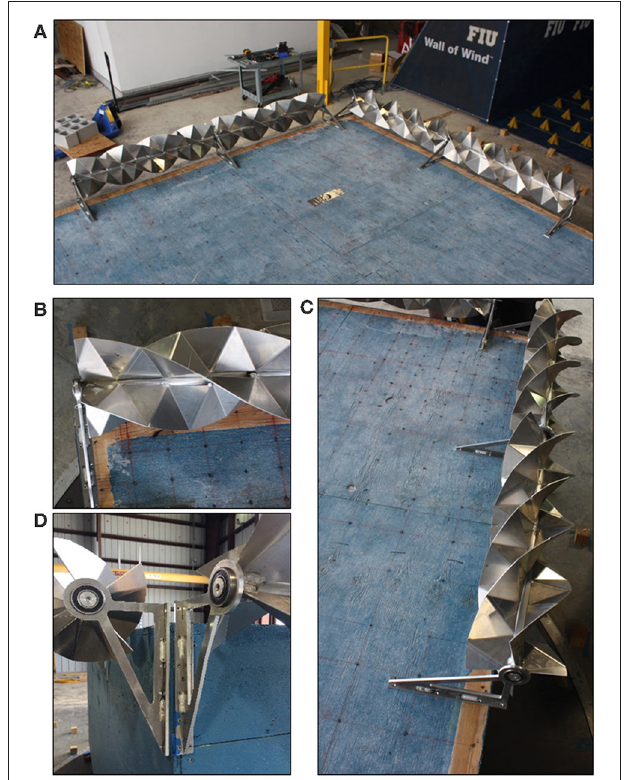
FIGURE 3 | (A) Wind turbine used for the study; (B) helical structure of the turbine blades; (C) turbine connected to the roof edge; (D) turbine connected to the building